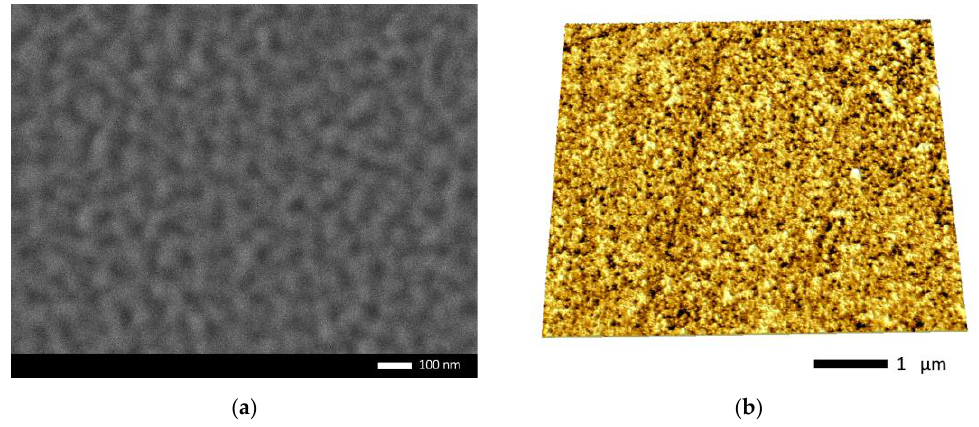
Figure 2. ( a ) Results of studying the surface morphology of the ZrO 2 ceramic samples in the initial state: ( a ) SEM image; ( b ) 3D surface reconstruction made using atomic force microscopy. As can be seen from the presented data, the roughness of the obtained samples after polishing bands was not observed on the surface.